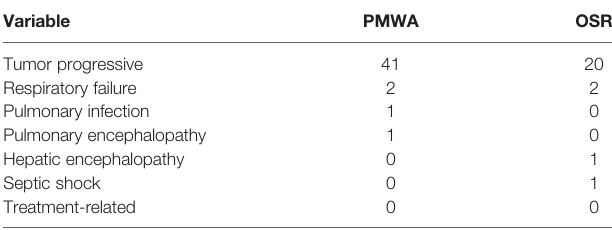
TABLE 2 | Cause of death during of follow-up.